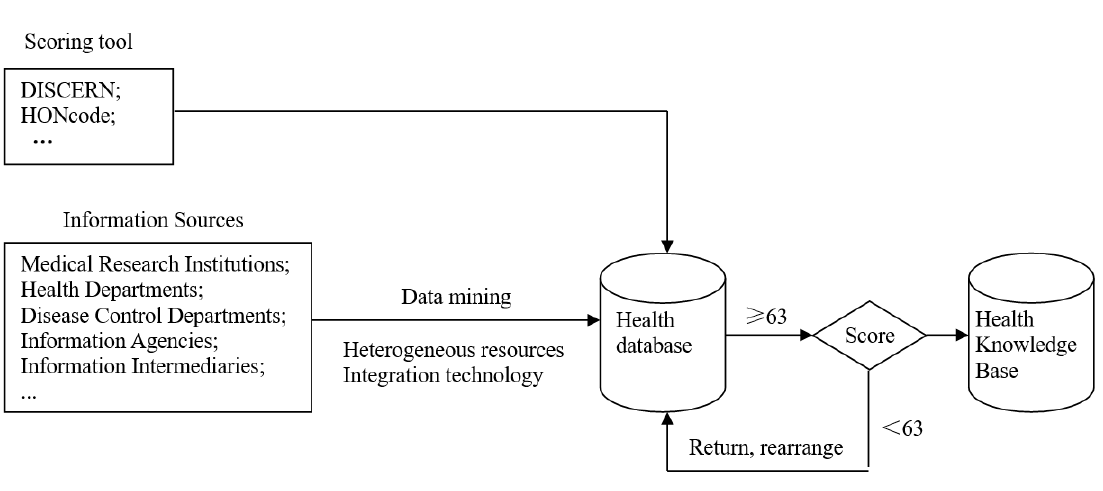
Fig. 3 Process of Health Information Resource